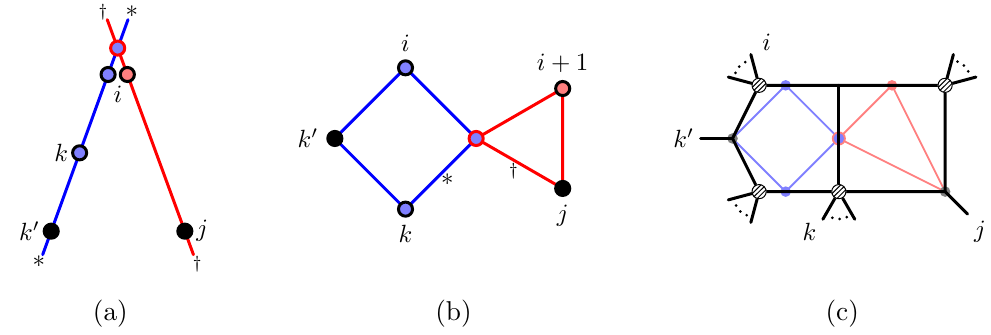
Figure 6 . Figure (a) is momentum twistor diagram (with the super(cid:13)uous edges associated with (1) (denoted with the external labels dropped), with the endpoints of ) identi(cid:12)ed, and with the L y (2) (denoted with *) identi(cid:12)ed. The resulting graph (b) comes from preserving the endpoints of L ordering of nodes along the line. Note we have used the ambiguity in ordering between k and k 0 to consider the case k < k 0 < i . Mapping any empty node to an edge between massive corners and mapping any (cid:12)lled node to a massless corner with two edges between massive corners, results in the Landau diagram (c). There would be a massive corner along the top of the Landau diagram, but the indices (cid:12)x that corner to be